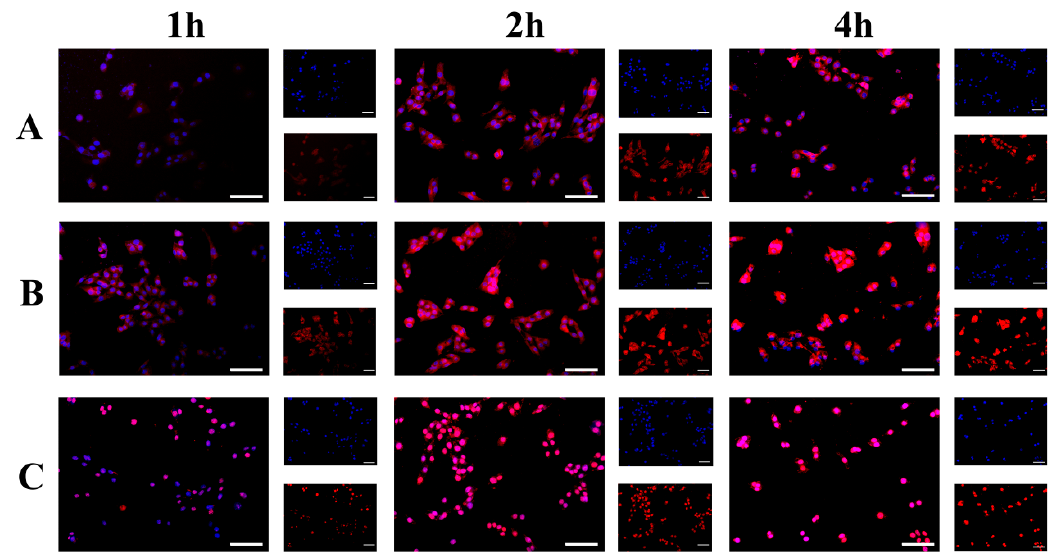
Figure 5. Fluorescence microscopy images of B16 cells incubated with ( A ) DOX/PAT, ( B ) DOX/PCT and ( C ) free DOX. Blue and red colors indicate nucleus and DOX, respectively (The bar is 200 μ m).